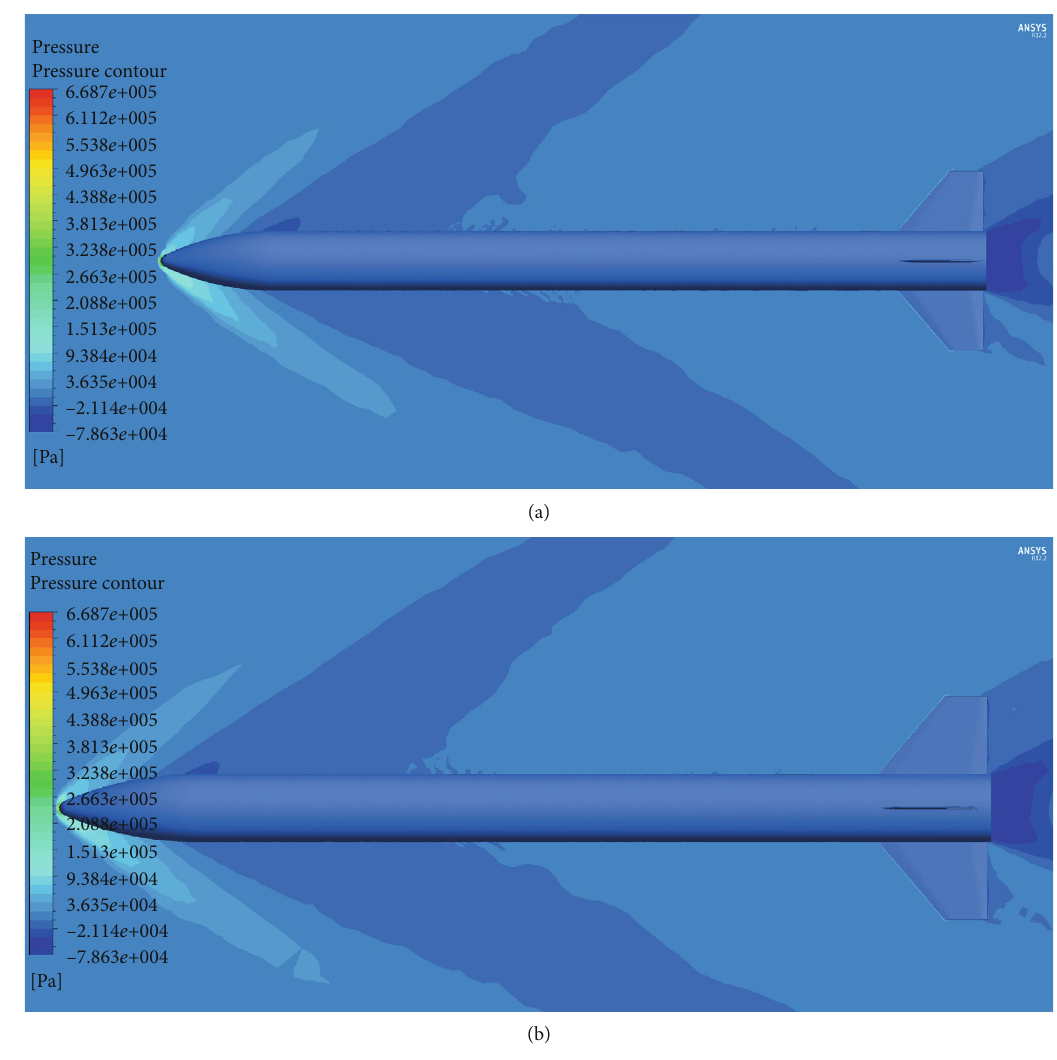
Figure 14: Comparison of the pressure contours of the optimum and baseline missile models at 2 Mach number and 4 ° AoA: (a) baseline model and (b) optimum